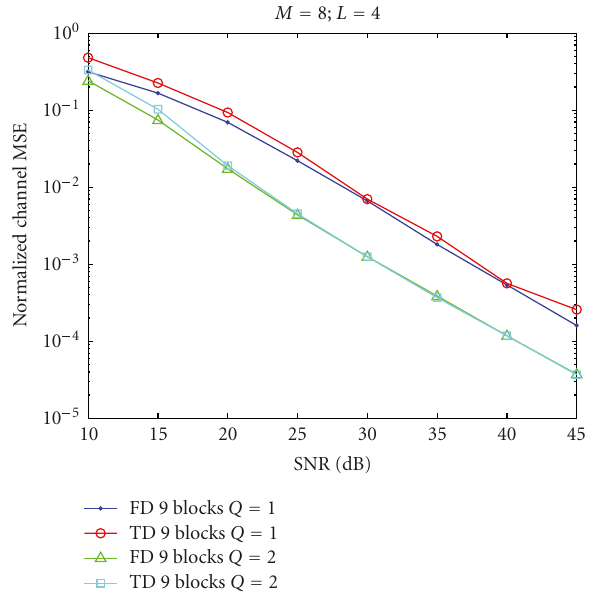
Figure 7: Normalized least squared channel error